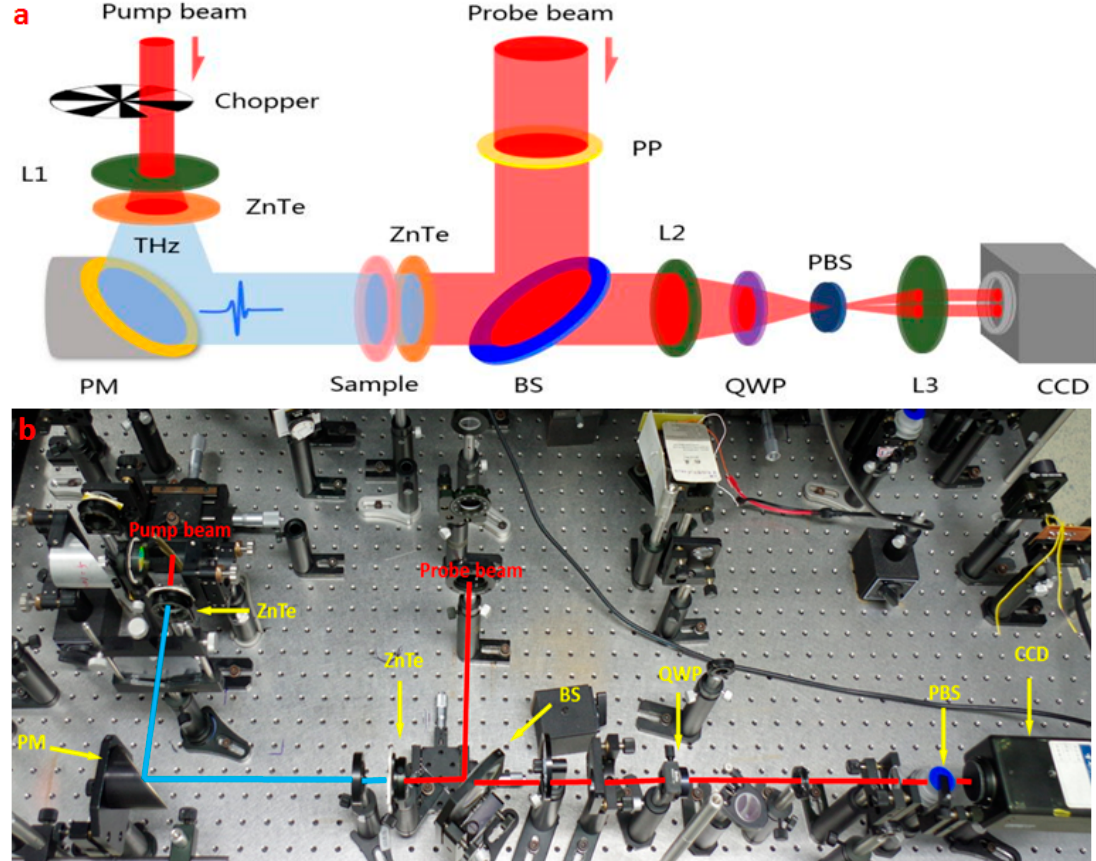
Figure 3. ( a ) Schematic plot and ( b ) photo of the terahertz (THz) time domain spectroscopy (TDS)- based charge-coupled device (CCD) imaging system: pump and probe beams come from a femtosecond laser from Spectra Physics with a center wavelength of 800 nm, a pulse width of 100 fs and a repetition rate of 1 kHz. L1 – L3, lenses; PM, parabolic mirror; BS, beam splitter; PP, polarization plate; QWP, quarter-wave plate; PBS, polarization beam splitter; CCD, charge-coupled device.